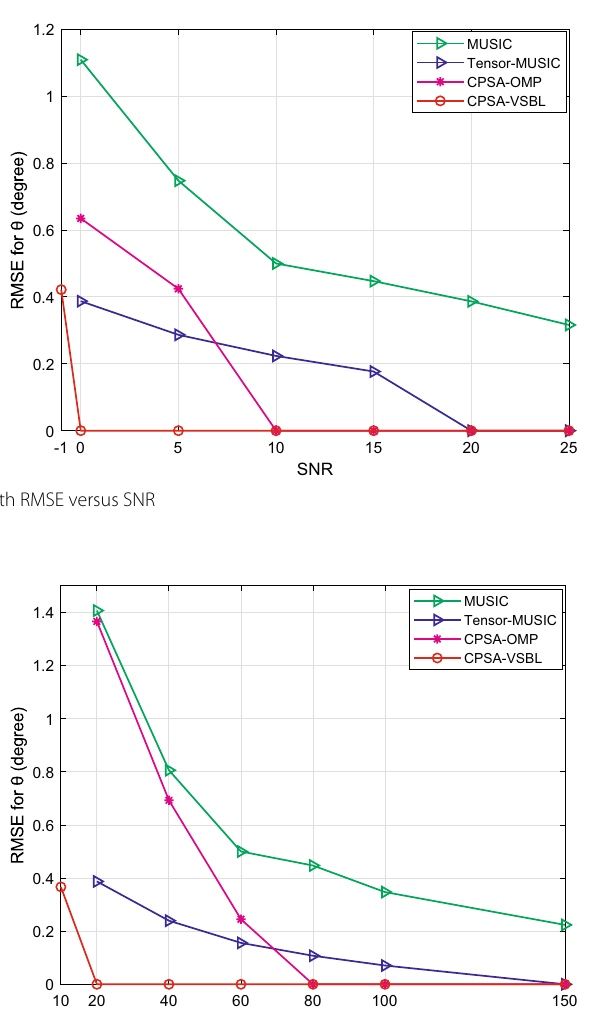
(cid:31) 2 . For simplicity, we assume M